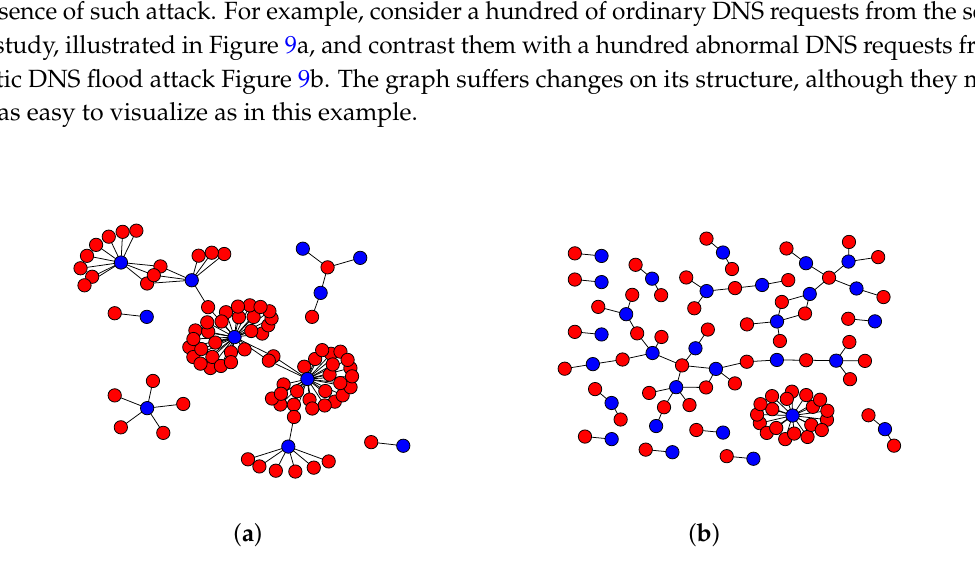
Figure 9. Example of a bipartite Domain Name System (DNS) graph. IP addresses and domain names are denoted by the color blue and red, respectively. ( a ) Ordinary DNS traffic from a recursive DNS server; ( b ) Synthetic DNS flood